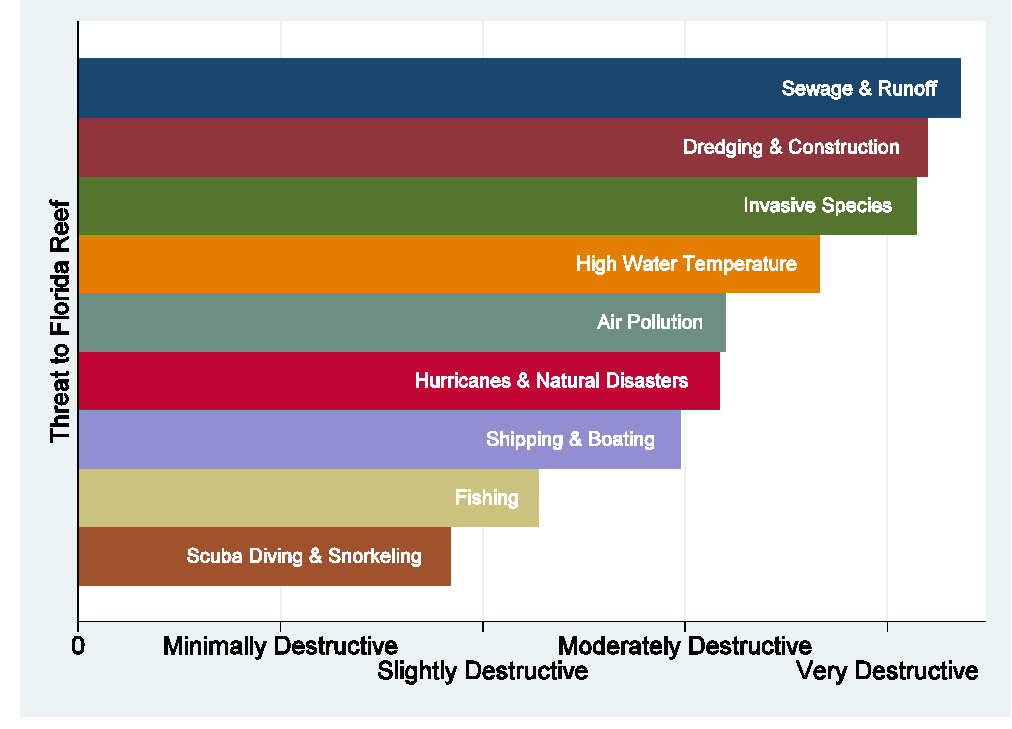
Figure 3. Perception of threats to the Florida Reef,